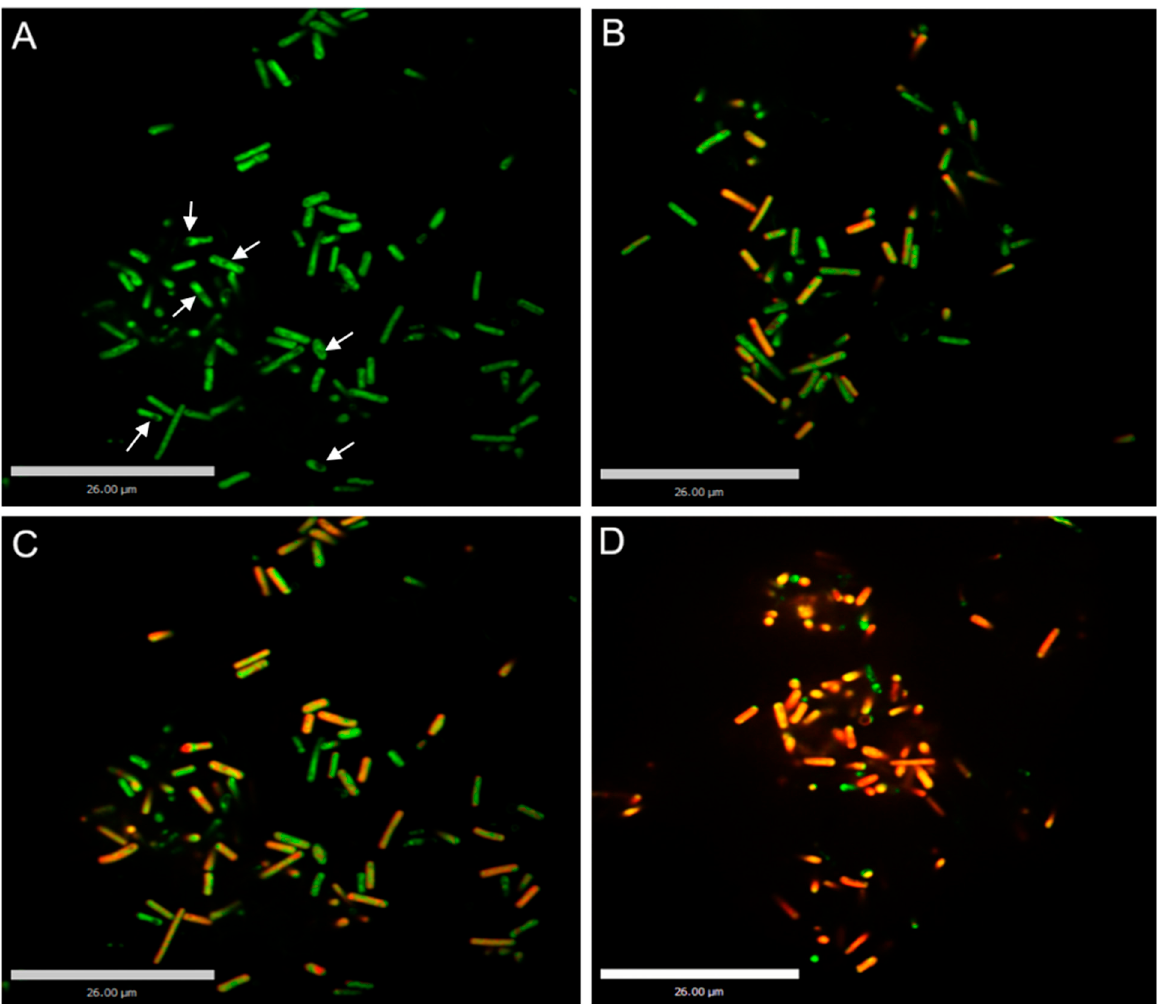
Figure 3. CLSM images of C. perfringens spores after different treatments for 30 min. ( A ), control; ( B ), treatment at 90 °C; ( C ), treatment with 1% LA; ( D ), combined treatment (90 °C and 1% LA). The white arrows referred to the spores.